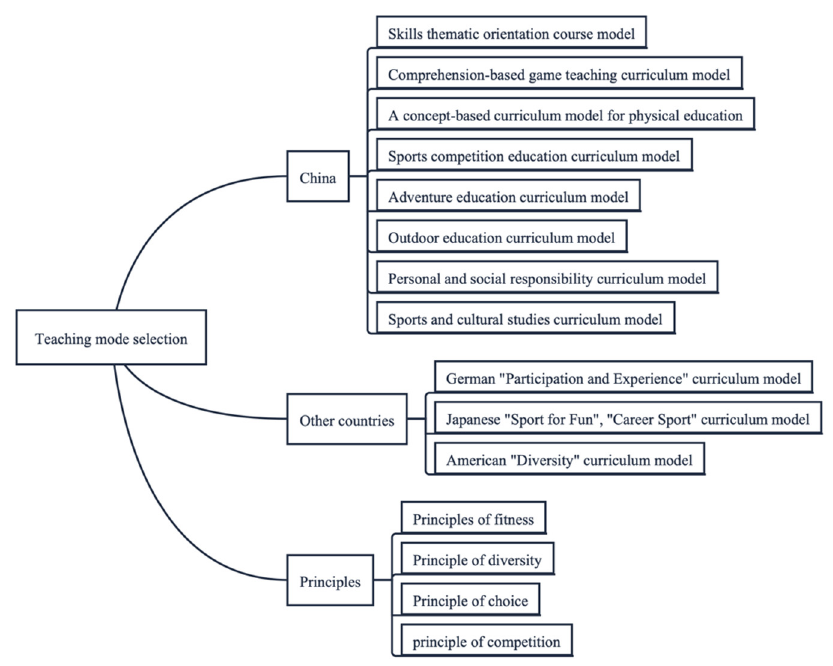
Figure 3. Figure showing the choice of teaching mode for the course.